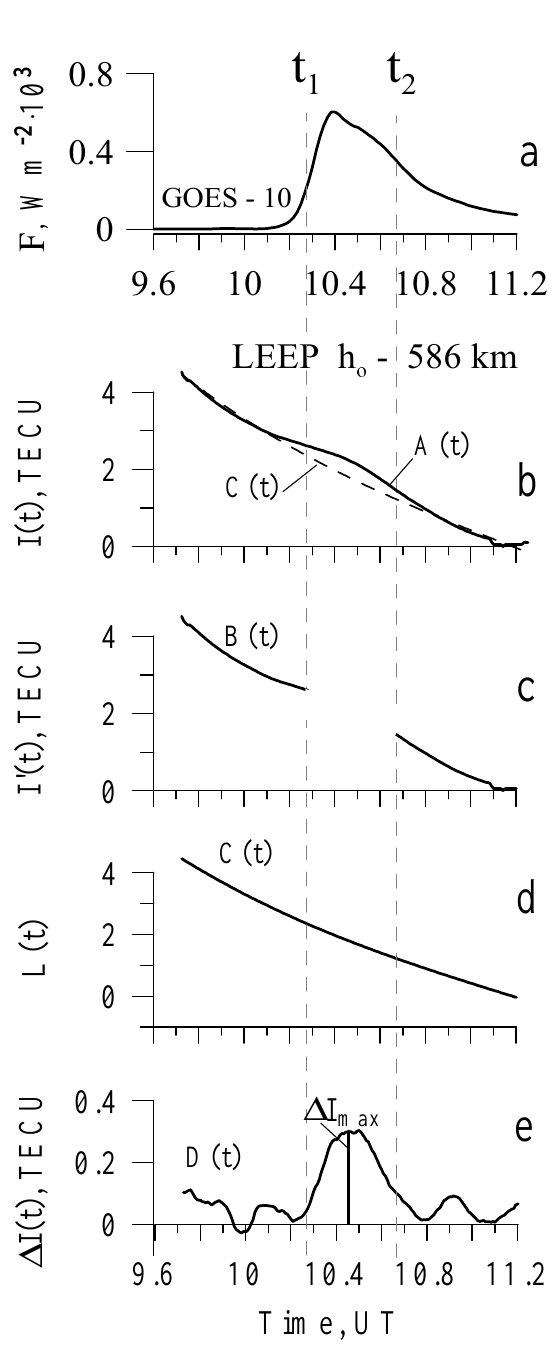
Fig. 2. Time profile of soft X-ray emission in the range 1– 8 ˚A(GOES-10 data) during the solar flare of 14 July 2000 (a) . Time dependence of TEC variations for the station LEEP A(t) (PRN07, shadow height ho = 586km) (b) , solid line. The same dependence after removal of counts in interval ( t 1 − t 2 ) (c) is represented by curve B(t). (d) is the curve C(t) (third-degree polynomial) approx- imating the time dependence B(t). This same curve is plotted in panel (b) by a dashed line. Time dependence of TEC variations D(t) upon subtracting the polinom (e)